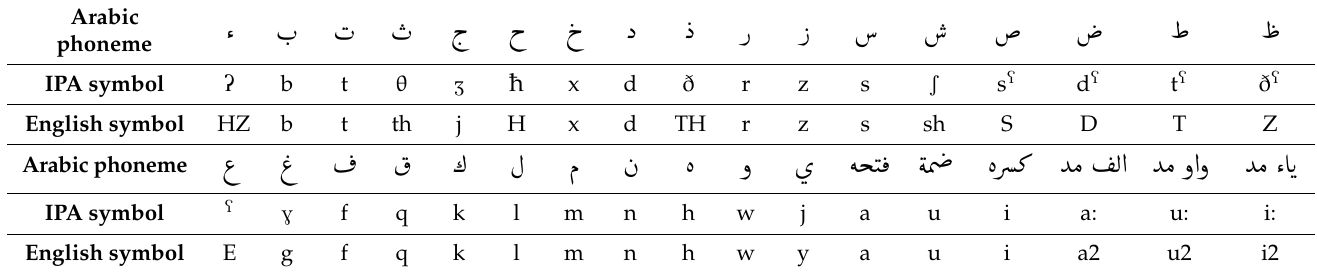
Table 2. Arabic phonemes, IPA symbols, and the corresponding English symbols used in this research.